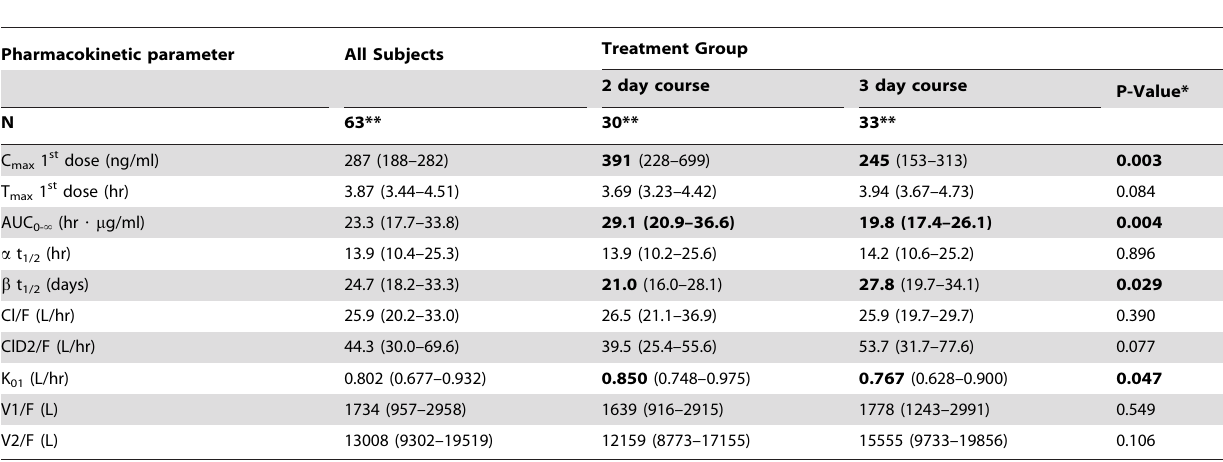
Table 3. Pharmacokinetic parameters calculated from a 2-compartment model comparing two versus three-day courses of DHA-